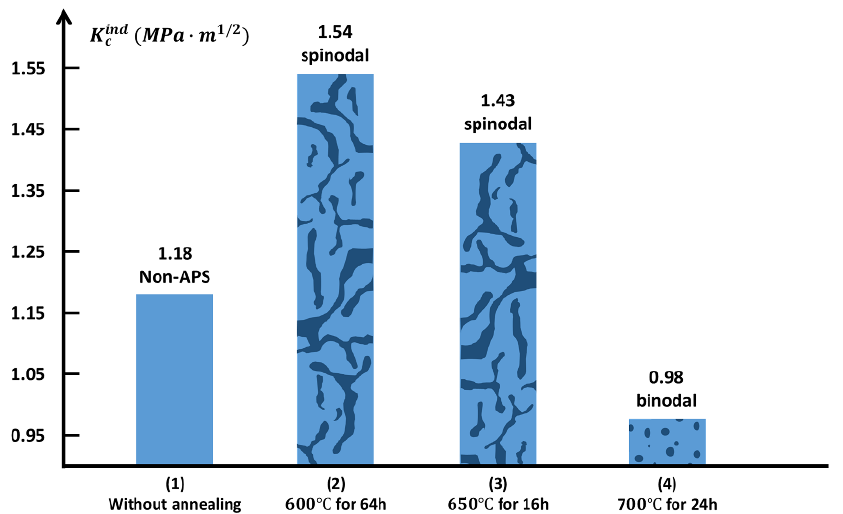
Figure 16. Comparison of indentation fracture toughness K ind c values for SBN glass with chemical composition [ SiO 2 ] = 60%, [ B 2 O 3 ] = 30%, and [ Na 2 O ] = 10% (in mol%) annealed at different temperatures for different durations: (1) without annealing (Non-APS); (2) 600 ◦ C for 64 h (spinodal structure); (3) 650 ◦ C for 16 h (spinodal structure); and (4) 700 ◦ C for 24 h (binodal structure). Recreated with data from [166].